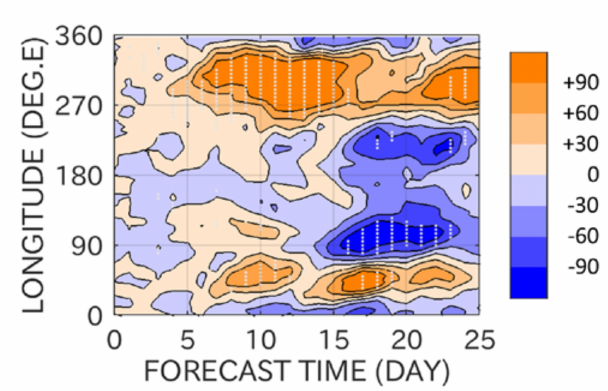
Figure 8. Forecast time–longitude section of the composite di ff erence of the MSSW members from the non-MSSW members in the MSSW ensemble for the first cluster. The di ff erence is averaged in latitude over 65 ± 10 ◦ N. Dots indicate where the di ff erence is significant at the 95% level. The dots are plotted every two longitudinal grids at most to avoid too dense plots.